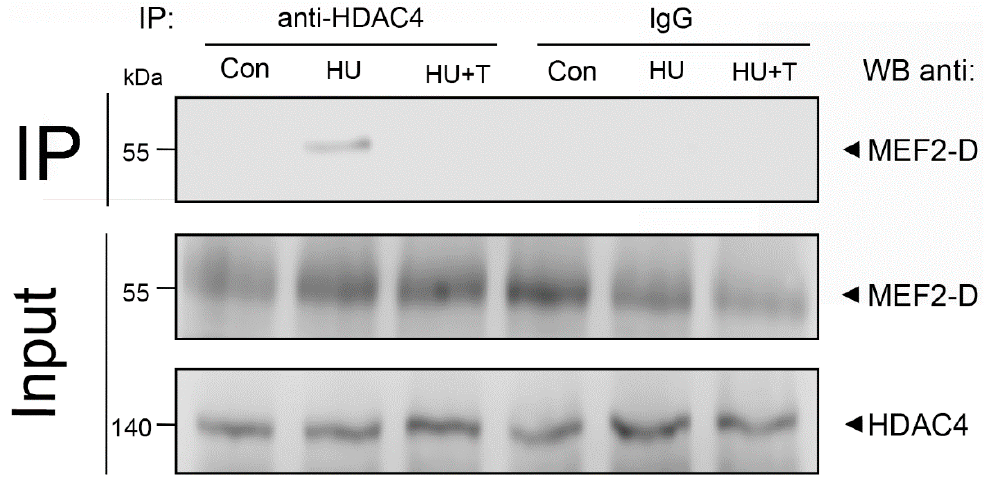
Figure 5. Co-immunoprecipitation of the HDAC4 with the